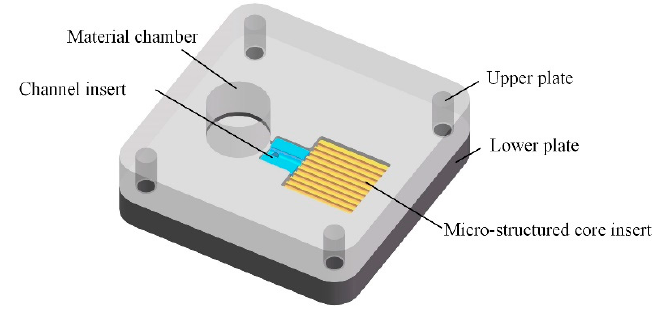
Figure 2. Micro-structured parts and surface morphology: ( a ) U-shaped; ( b ) semi-circular; ( c ) V- shaped.